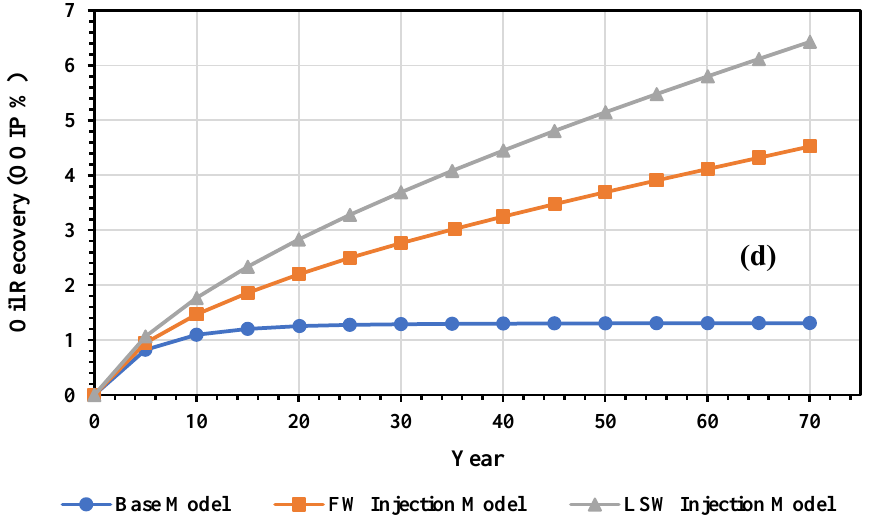
Figure 8. The influence of LSW injection on ( a ) oil rate daily production, ( b ) water cut, ( c ) cumulative water production, and ( d ) oil recovery in three models: the base model (the injection water is not implemented and is produced by natural pressure), formation water injection model, and LSW (with a salinity of 0.1%) injection model of the Kashkari oil field.